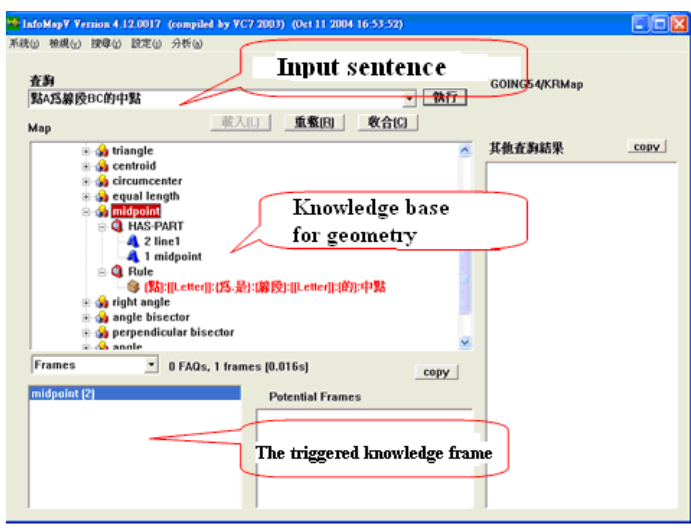
Figure 5. Inquiring a knowledge base of